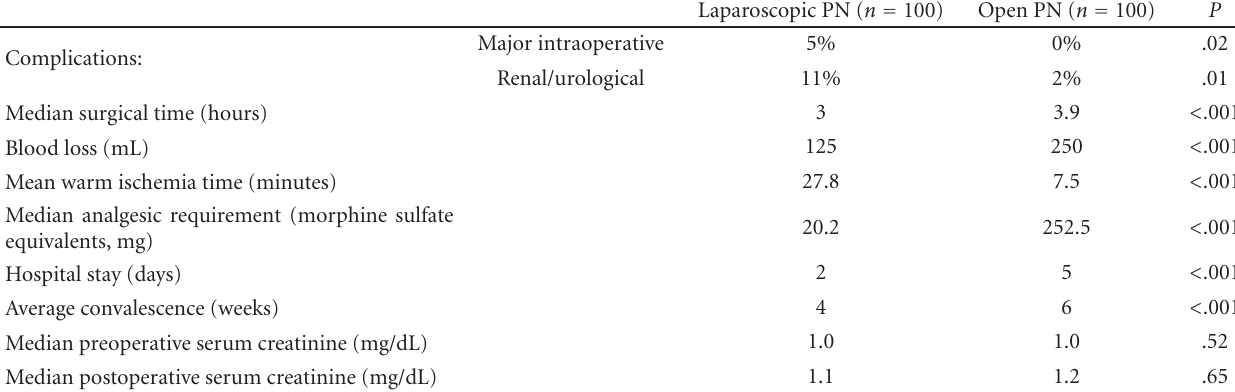
Table 4: Comparison of laparoscopic versus open PN in patients with a solitary renal tumor of 7 cm or less in size (table modified from